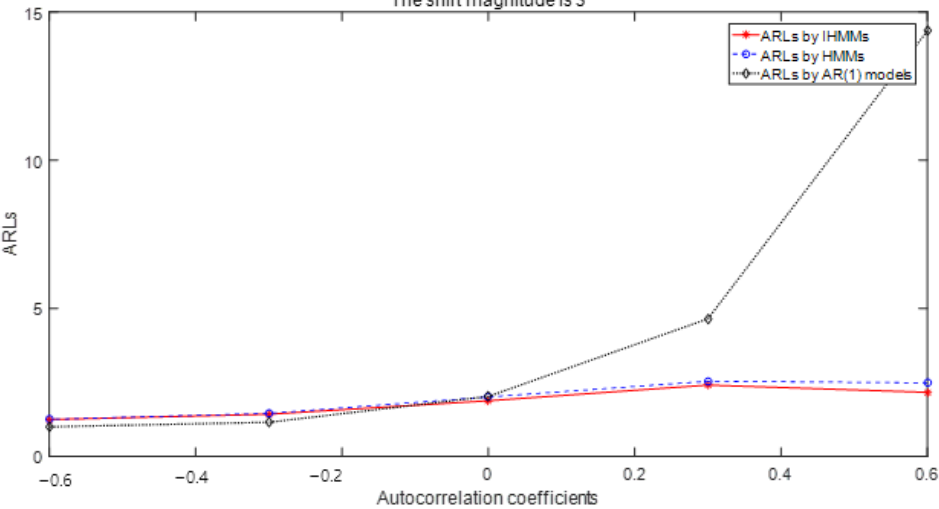
Figure 7. The ARLs of residual charts obtained by different models when the shift magnitude is